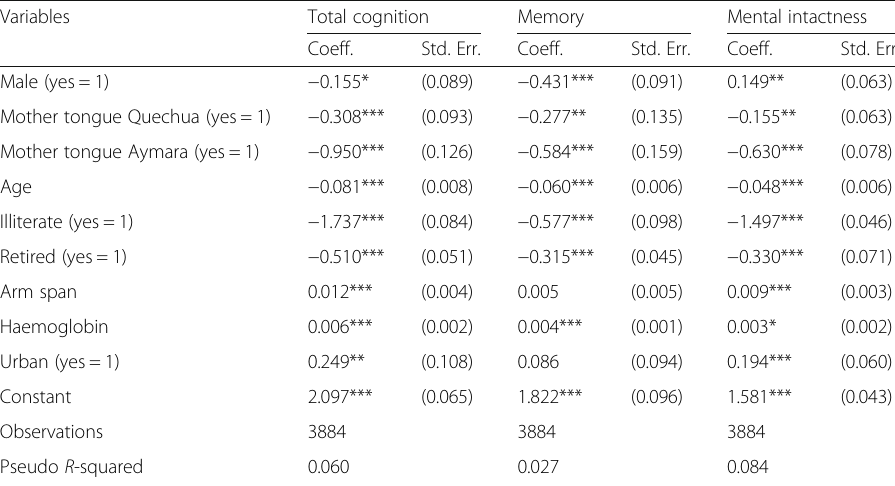
Table 4 Tobit estimates for dimensions of cognition in old age Variables Total